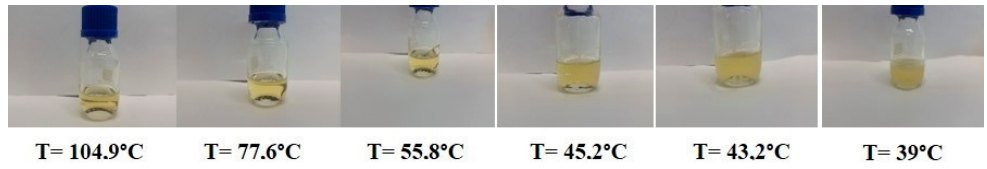
Figure 1. Visible phase change for a 12% polymer concentration solution.